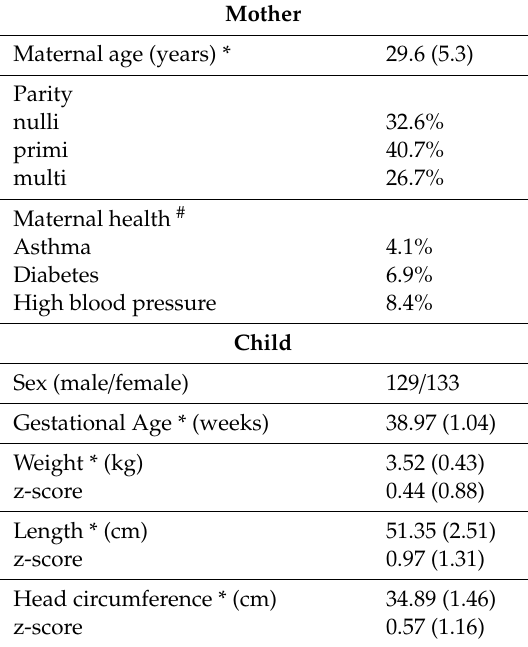
Table 1. Details of mothers and newborns.